Question: What kind of plot is shown here?
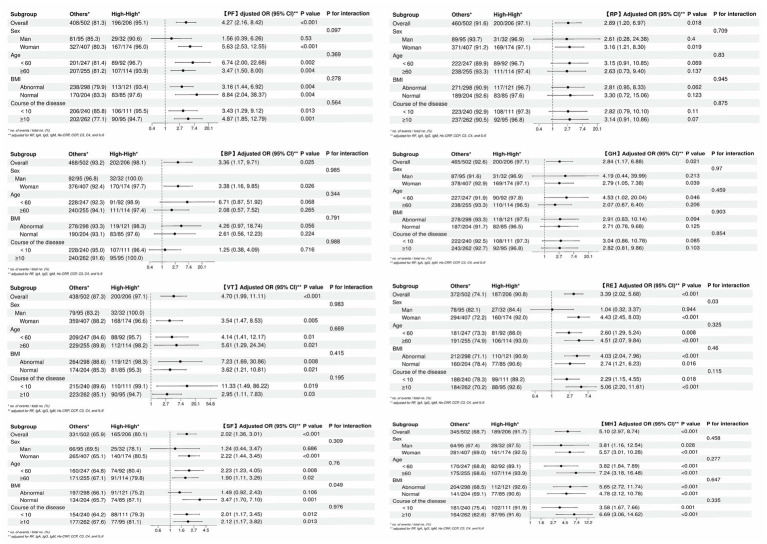
Answer: forest